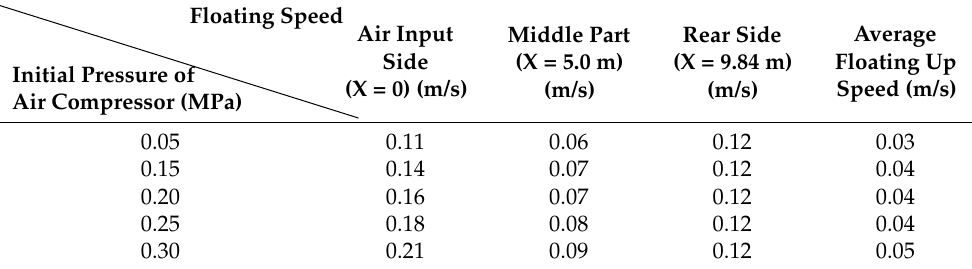
Table 6. Floating speed of the model hose net.